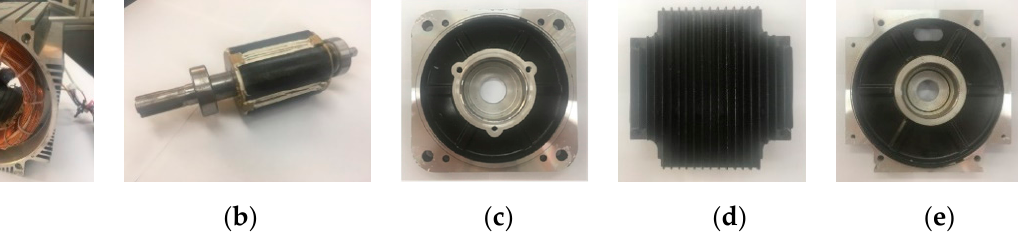
Figure 1. The BLDC Motor: ( a ) stator, stator winding, and stator housing; ( b ) rotor, permanent magnets, rotor shield, and bearings; ( c ) front end shield; ( d ) fin; ( e ) back end shield. Table 1. Parameters of BLDC motor.